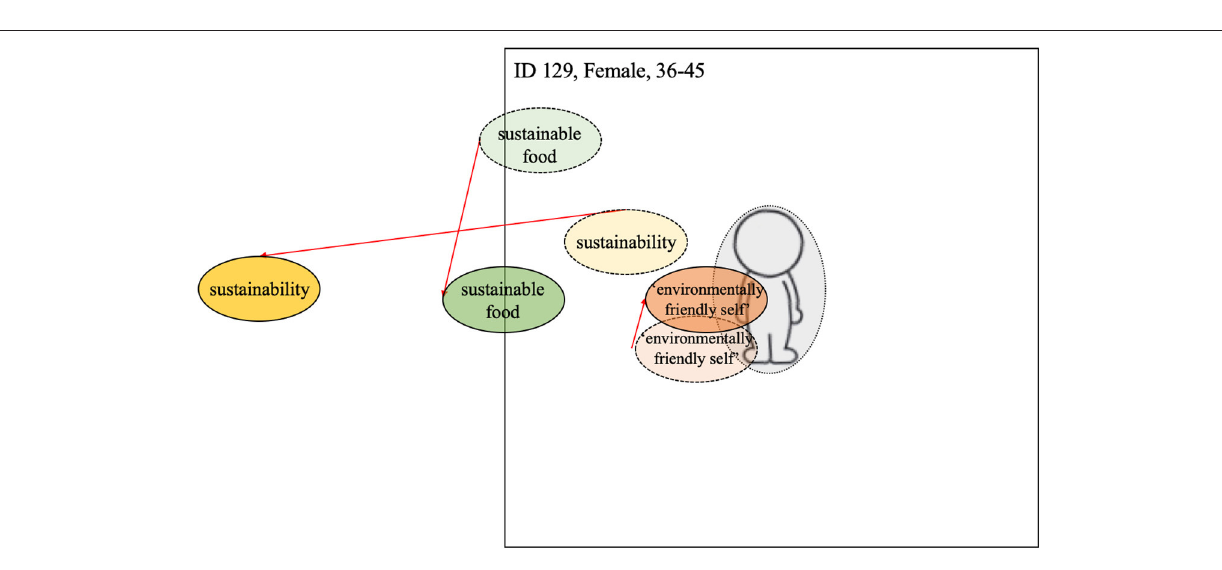
participants evidencing a more benign lack of spillover